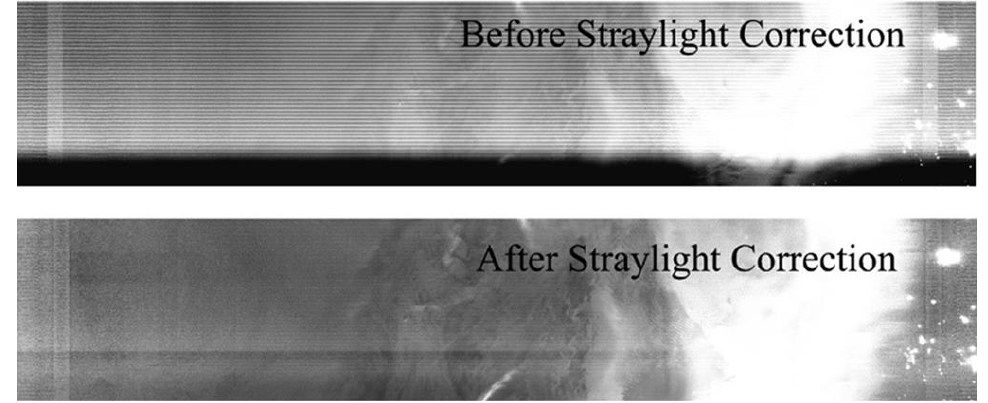
Figure 9. Sample DNB granule ( Top ) before and ( Bottom ) after straylight correction over the northern hemisphere. ( Top ) Operational radiance (16 December 2012) before straylight correction. ( Bottom ) Reprocessed radiance after straylight correction